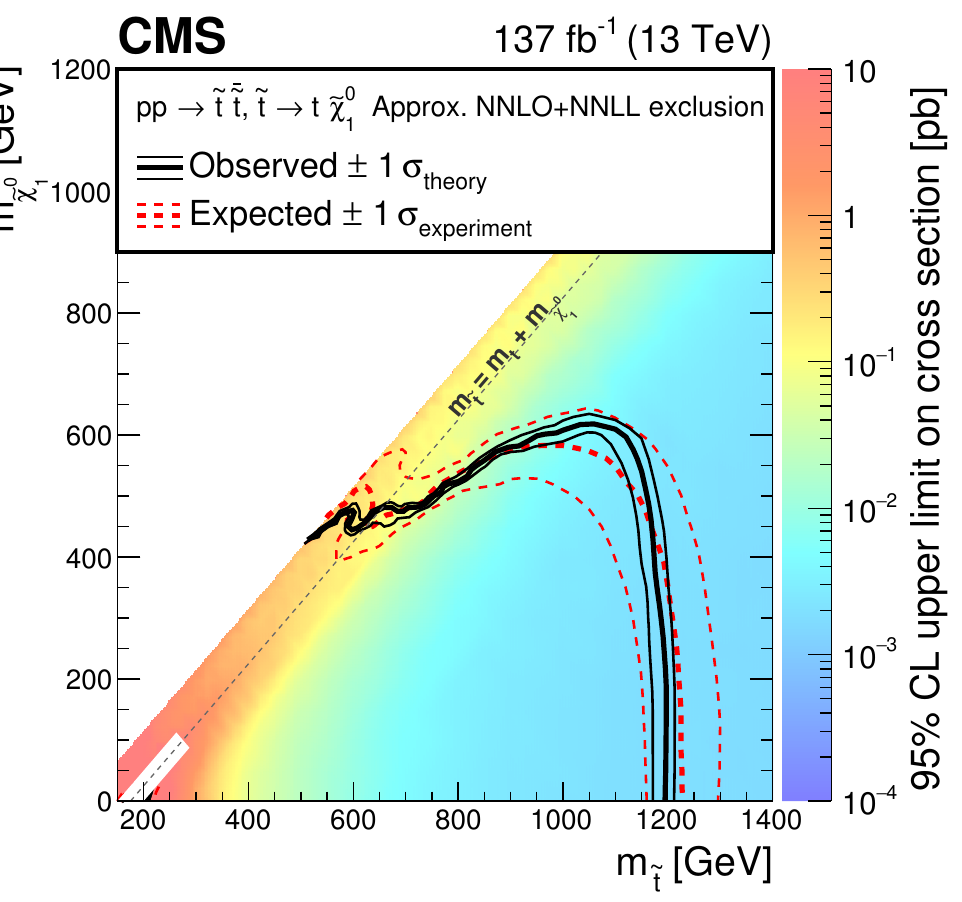
(cid:31) 0 scenario. The colored map 1 1 e (cid:0) m (cid:0) m j < 25 GeV ; m < 275 GeV, where the 0 t e t e t 1 e (cid:31)